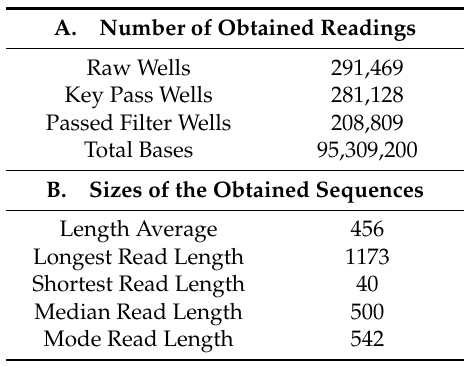
Table 2. Roche 454 sequencing results for the head kidney transcriptome of Eleginops maclovinus .